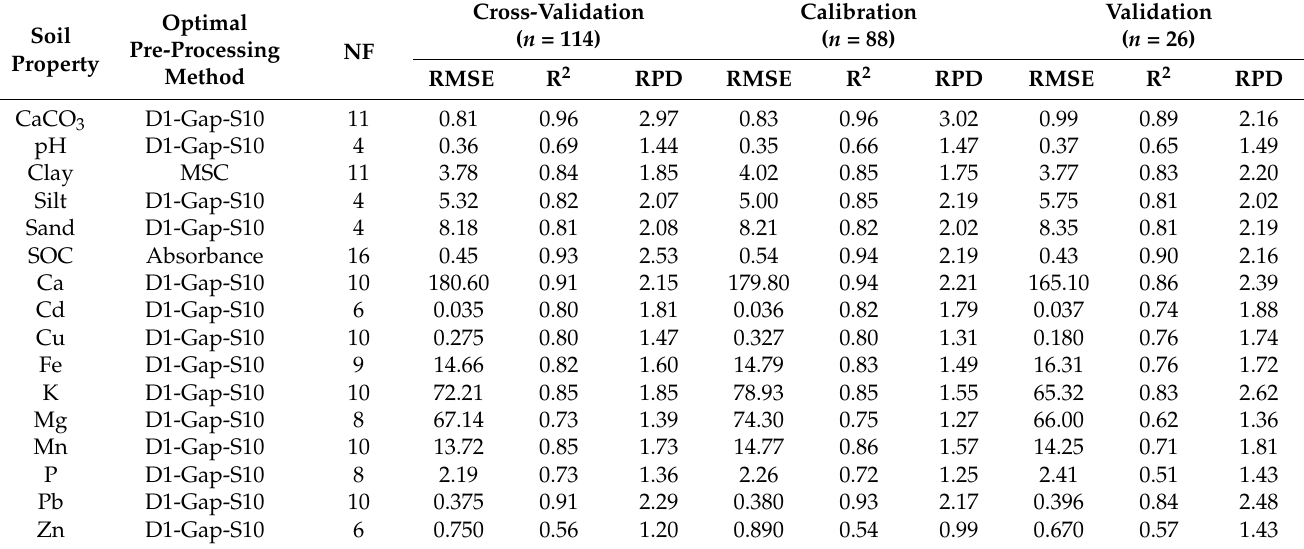
Table 3. Statistics of cross-validation, calibration, and validation prediction for each soil constituent based on the optimal pre-processing